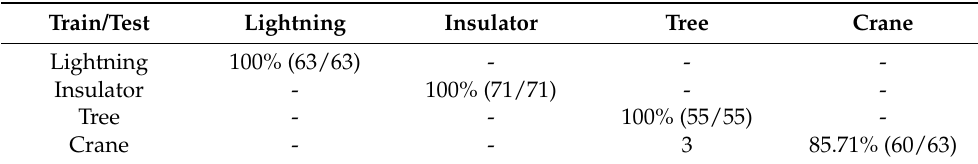
Table 9. Accuracy of the created decision tree w.r.t. curvature predictor selection on test set data for 70% training and 30% testing.